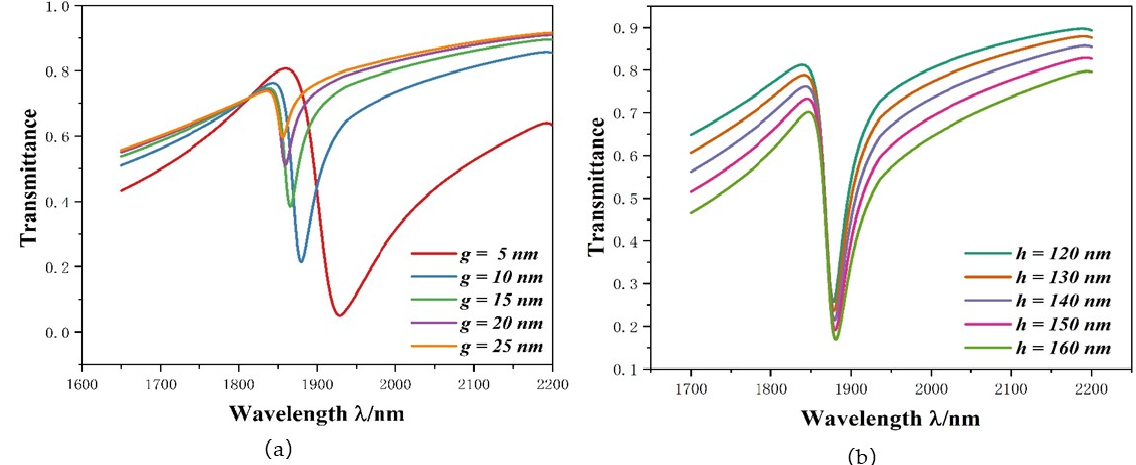
Figure 7. ( a ) Transmission spectra at disparate coupling distances; ( b ) Transmission spectra for different height of stub-1.